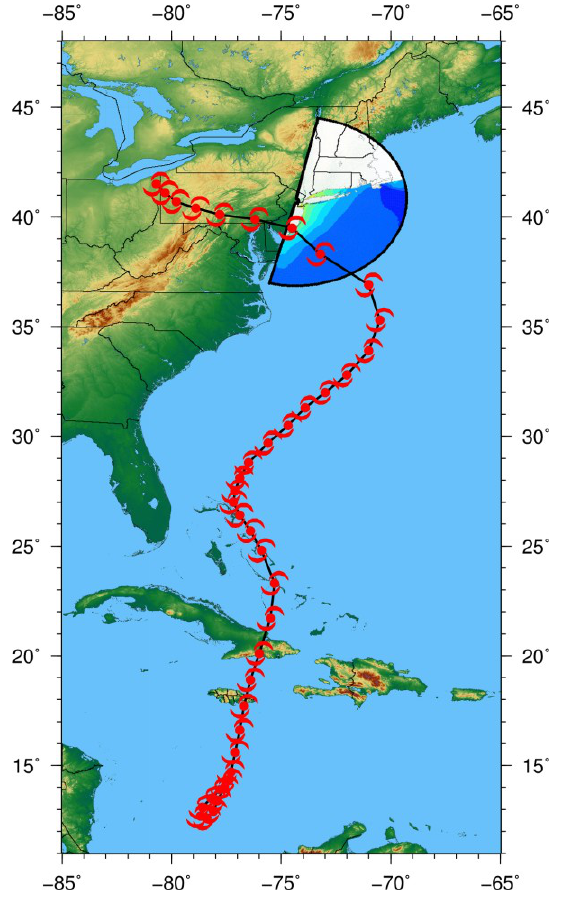
Figure 3. Hurricane Sandy track and the storm tide (m) simulated by the Sea, Lake, and Overland Surges from Hurricanes (SLOSH) numerical storm surge prediction model in the ny3